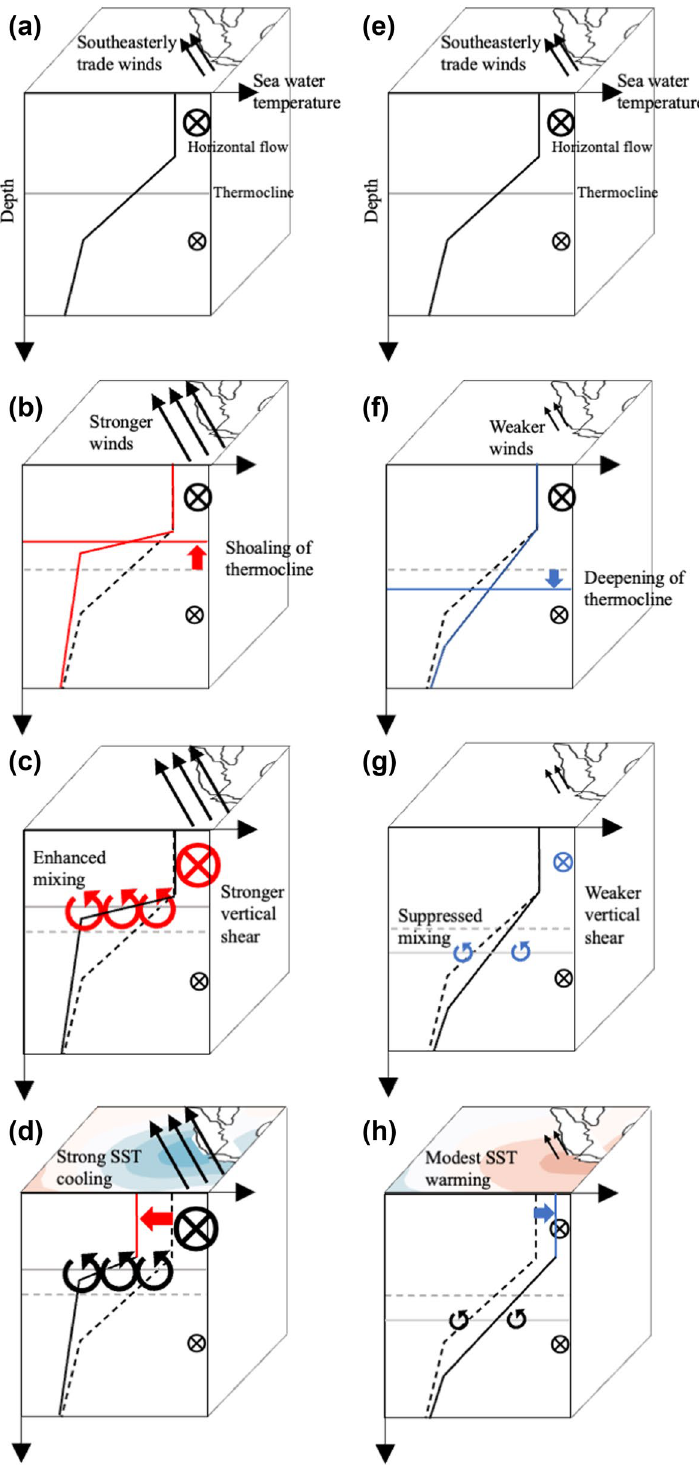
Figure 8. Schematic diagrams explaining how the vertical mixing contributes to the SST asymmetry. Schematic representation of the anomalous vertical mixing term for the pIOD ( a – d ) and the nIOD ( e – h ). The shading in ( d ) and ( h ) indicates SST